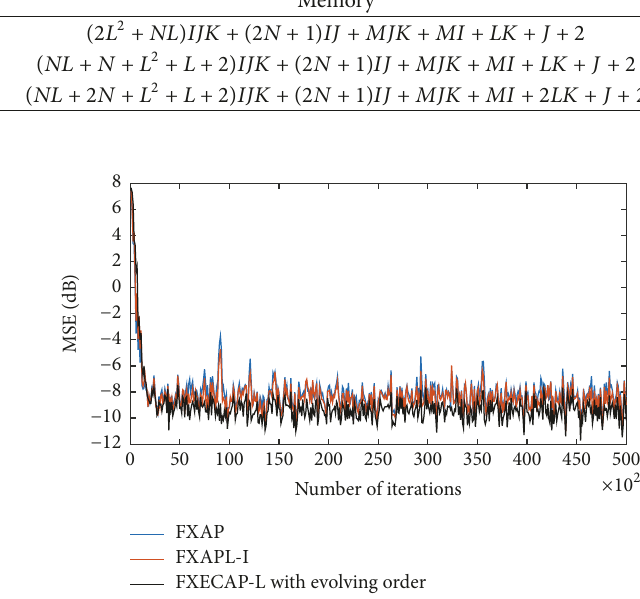
Figure 3: MSE values of the tested AP algorithms for a projection order of 𝐿 = 5 when 𝑏 = 8 bits are used to encode the error.